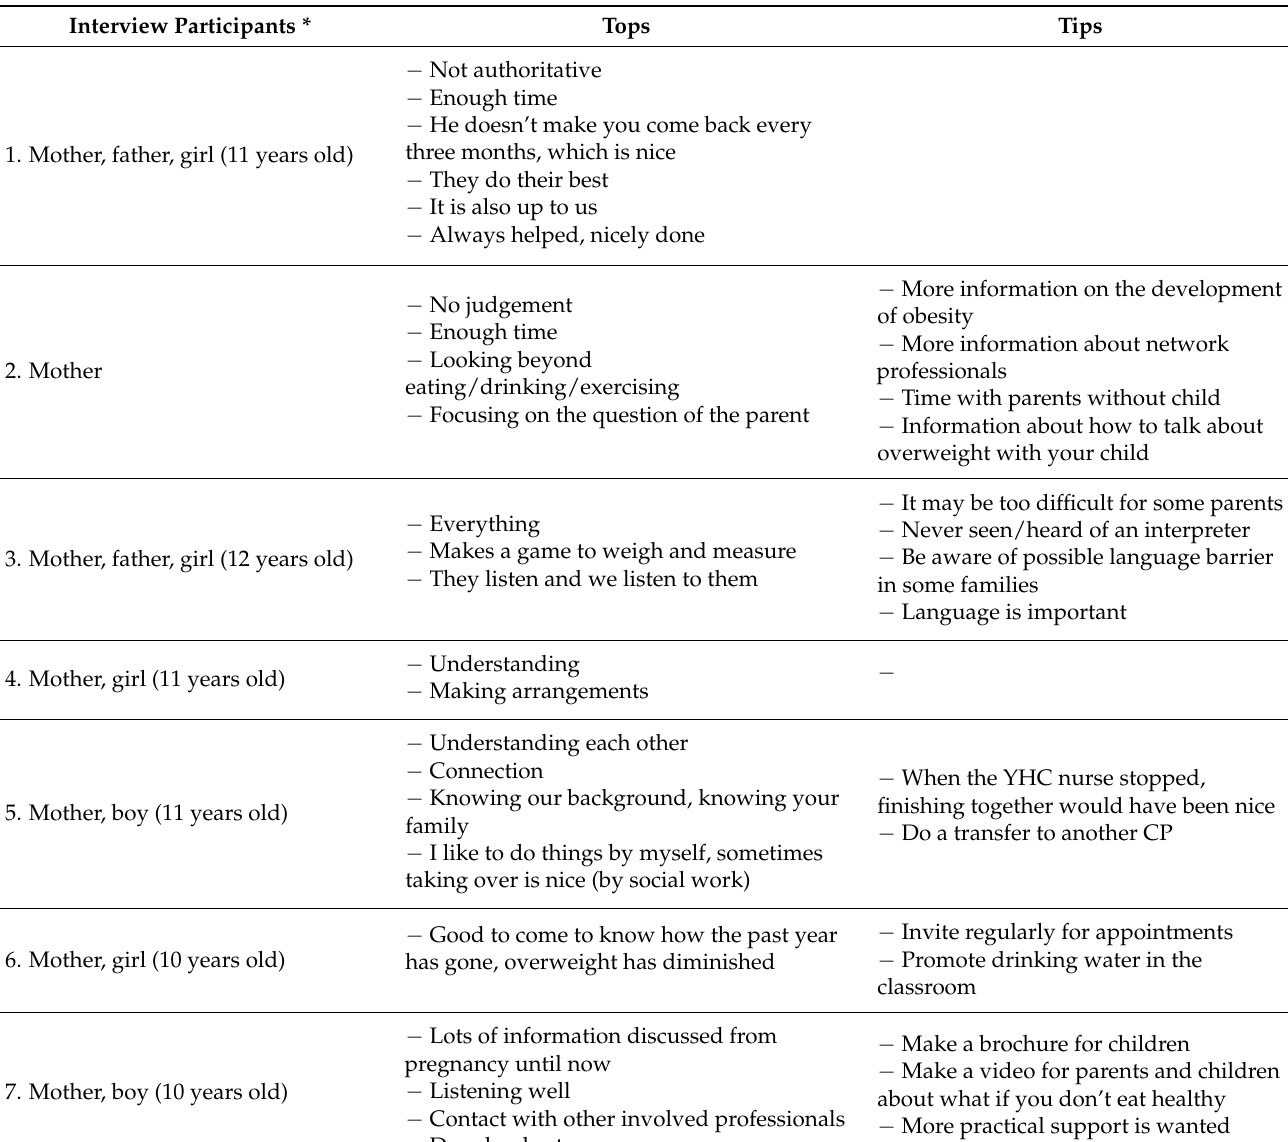
Table 4. Points of appreciation (tops) and improvement (tips) by parents and